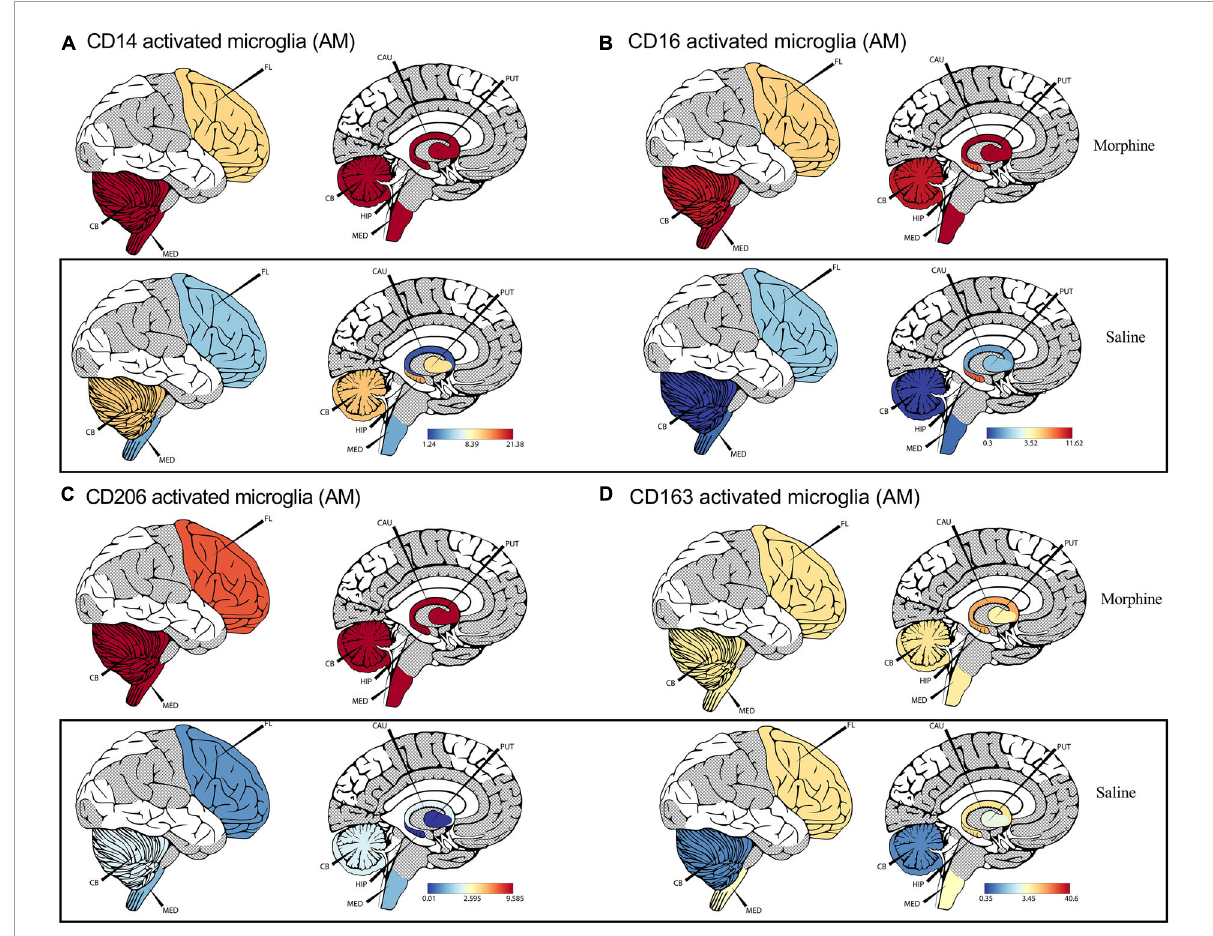
FIGURE3 Morphine induces differential CD14, and CD163 profiles within diverse brain regions in simian human immunodeficiency virus (SHIV) infected rhesus macaques exposed to saline ( n = 4) or morphine ( n = 4). (A) CerebroViz visualization highlighting the anatomic distribution of (A) surface CD14, (B) surface CD16, (C) surface CD206, (D) surface CD163 on activated microglia contained within the frontal lobe (FL), cerebellum (CB), medulla (MED), Putamen (Put), Hippocampus (Hip), Caudate nucleus (CAU) in replacement of the subventricular zone (SVZ) activated microglia for visualization